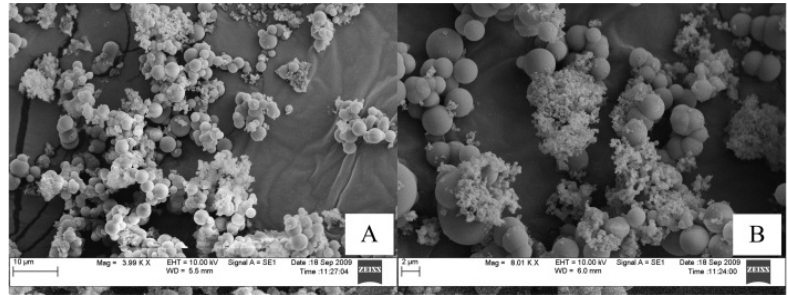
Figure 6. SEM image of biochar (HTC of biocrude obtained at 200 °C), 200 °C, 2.0 h. ( A : scale: 10 μ m; B : scale: 2 μ m.)